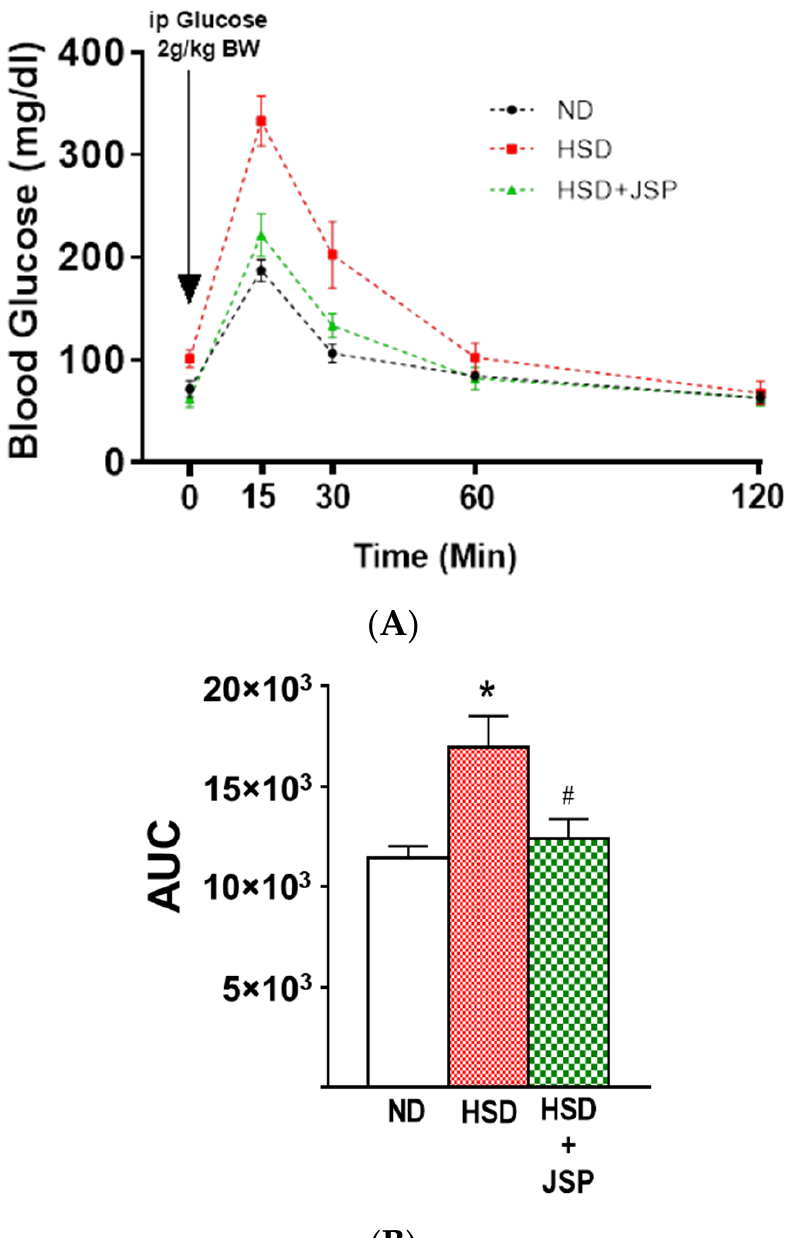
Figure 3. JSP supplementation with HSD improved glucose tolerance. ( A ) Blood glucose content was measured at 0, 15, 30, 60, and 120 min after i.p. glucose (2 mg/kg BW) administration; ( B ) The area under the curve (AUC) for glucose tolerance test was quantified. ND: Normal Diet; HSD: High-Sugar Diet; and JSP: Jackfruit Seed Powder. * p < 0.05 vs. ND; # p < 0.05 vs. HSD by one-way ANOVA followed by Tukey’s post hoc test. Bars represent mean ± SEM. n ≥ 3 for each group.